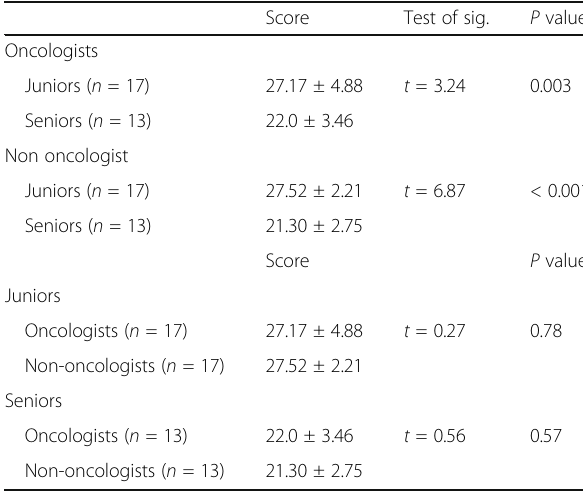
Table 4 Comparison between either juniors or seniors (oncologists or physician non-oncologist) and the mean score of Work Place Stress